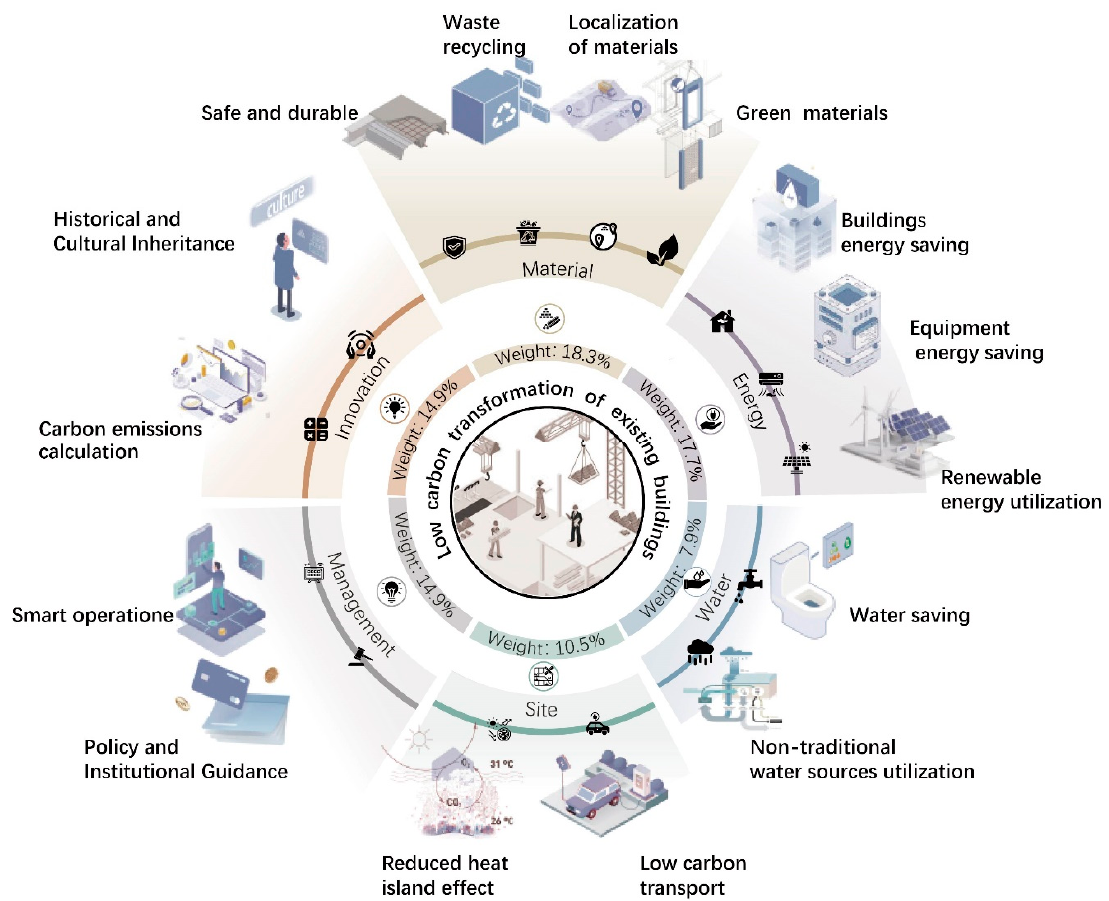
Figure 12. The low-carbon retrofitting path for existing buildings.